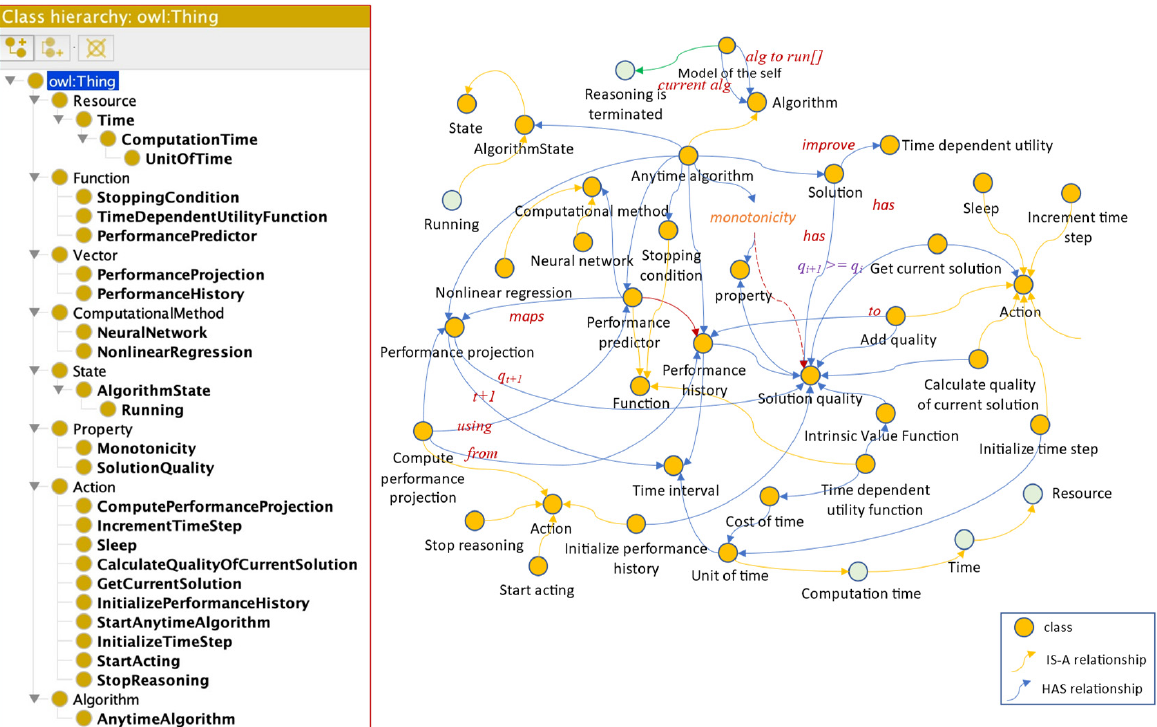
Figure 9. The SRP subontology.